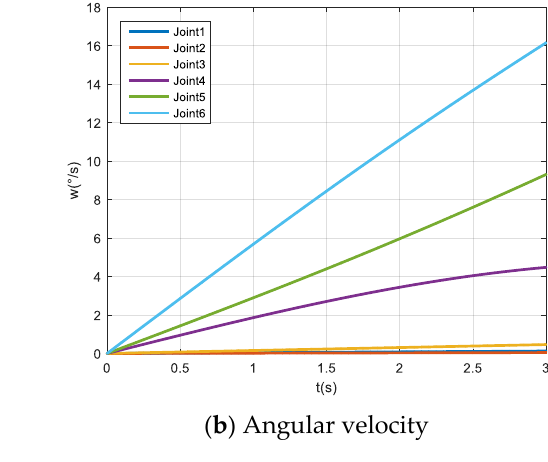
Figure 8. MATLAB simulation results.